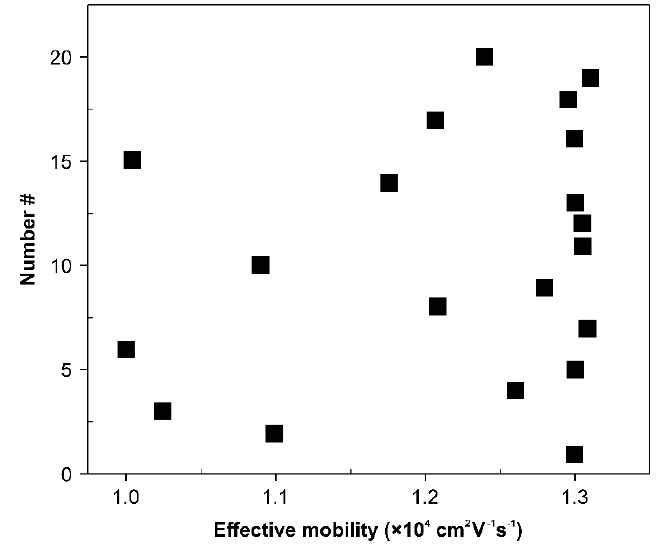
Figure 3. Distribution of the effective field effect mobility of 20 all-CNT-based FETs. When the size of the CNT channel is 8 mm in length and 1 mm in width, the average mobility is 1.2 × 10 4 cm 2 V − 1 s − 1 .